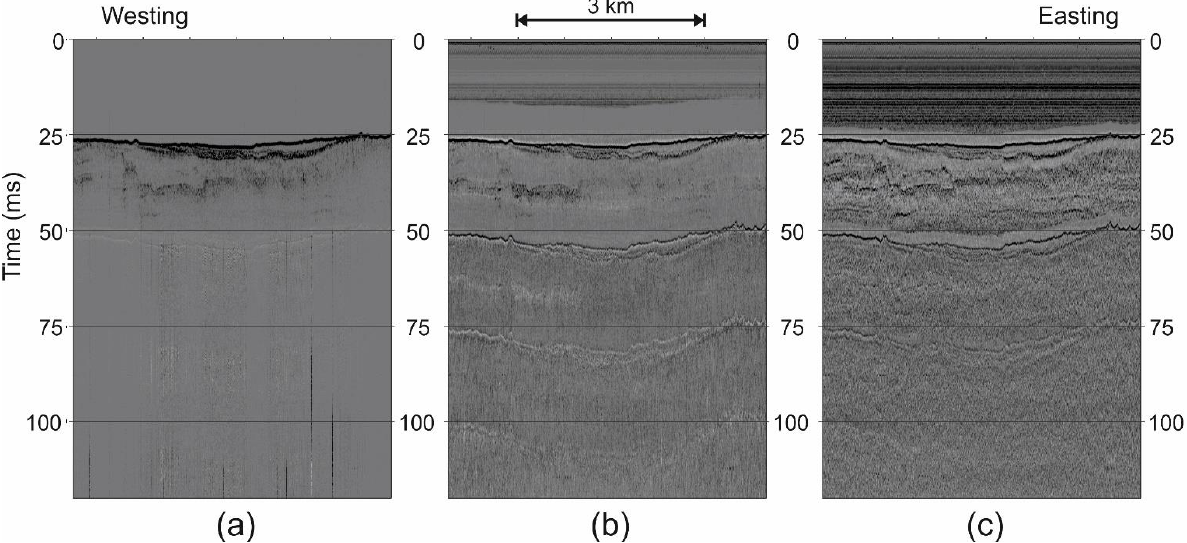
Figure 6. Gapped deconvolution applied in two steps ( a ) and after the AGC using the two windows as in Figure 3, i.e., 10 ms ( b ) and 3 ms ( c ). After AGC, the multiples’ residuals are much stronger than those obtained using any t α gain curve (Figure 5).